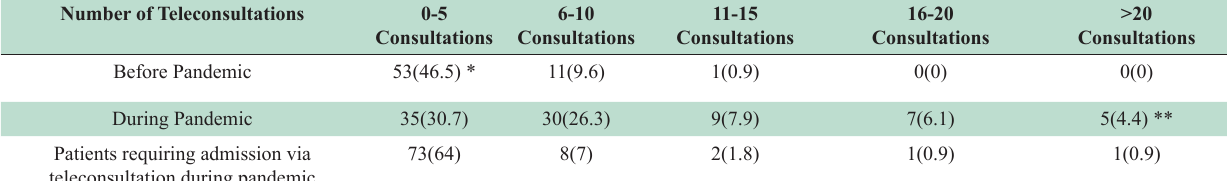
Table-V: Range of teleconsultations per week by pediatricians